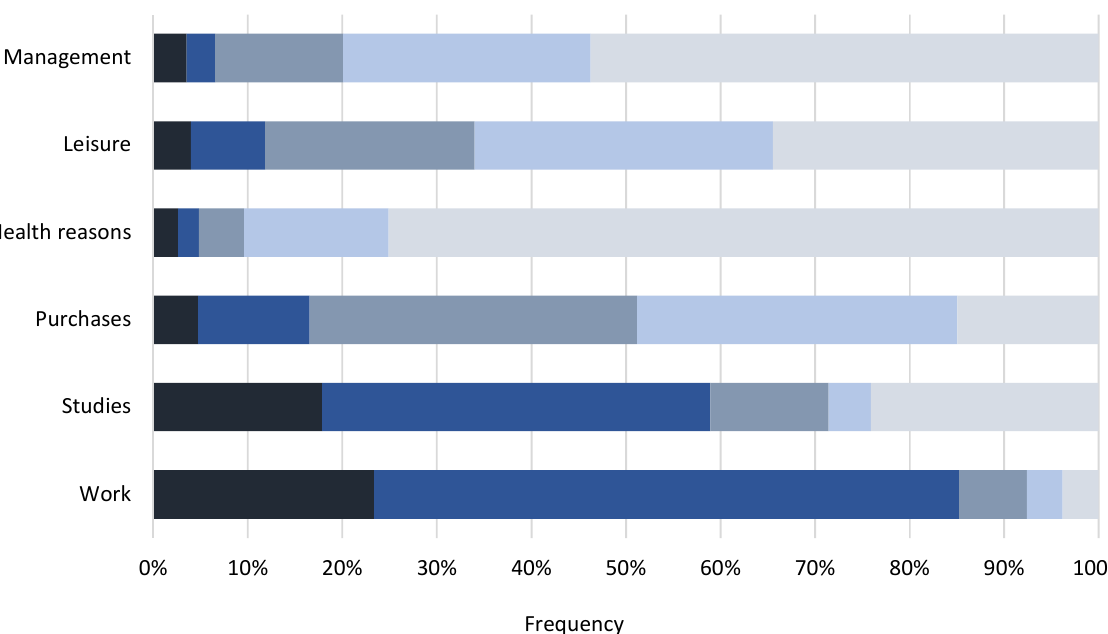
Figure 8. Frequency of trips by purpose of travel.